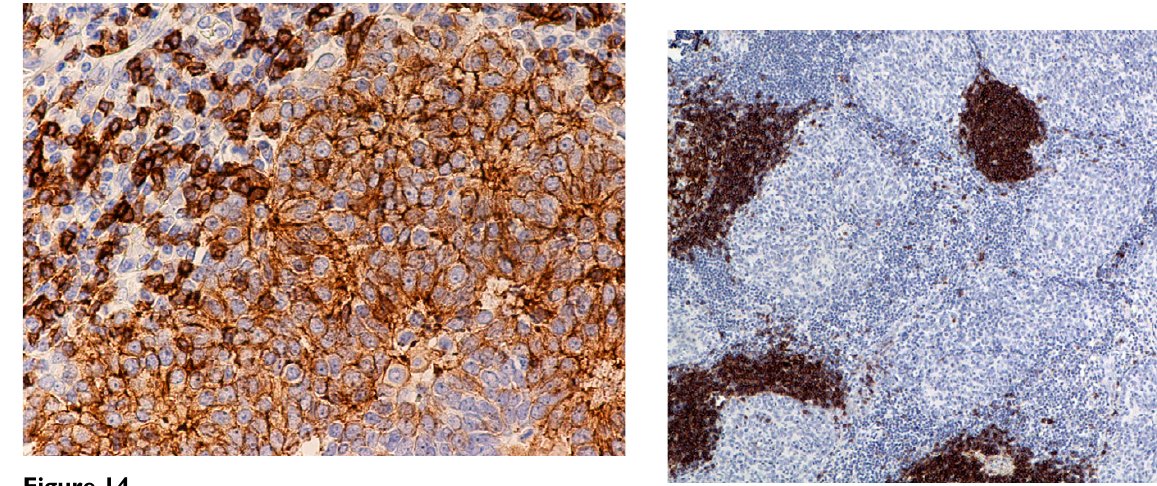
Figure 14 (B-SA, anti-bcl-2, × 400): Type B3 thymoma. Note strong expression of bcl-2 in neoplastic epithelial cells and back- ground lymphocytes.